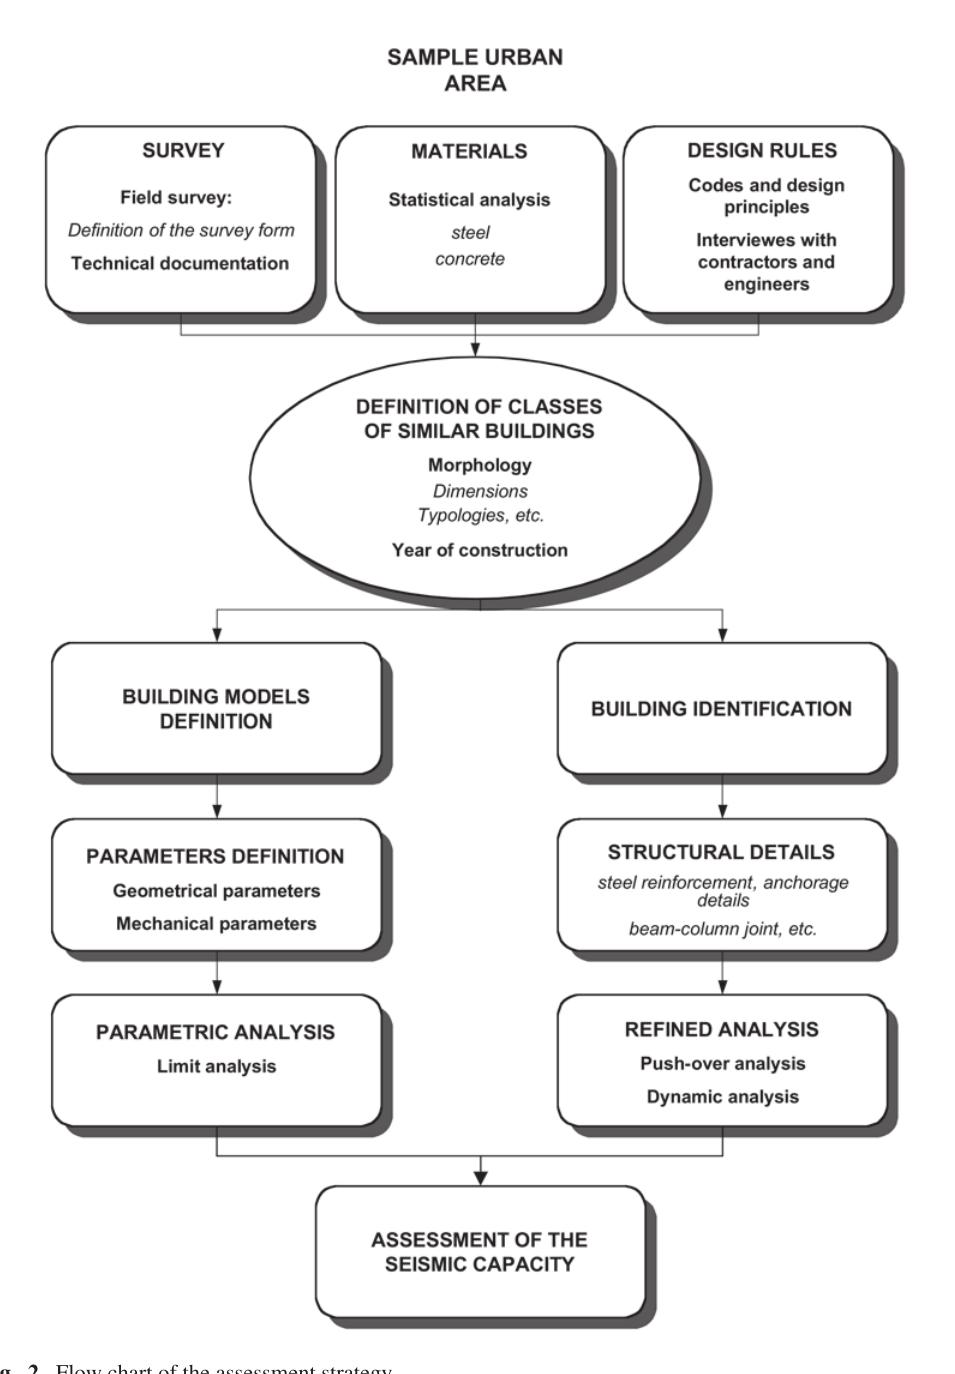
Fig. 2. Flow chart of the assessment